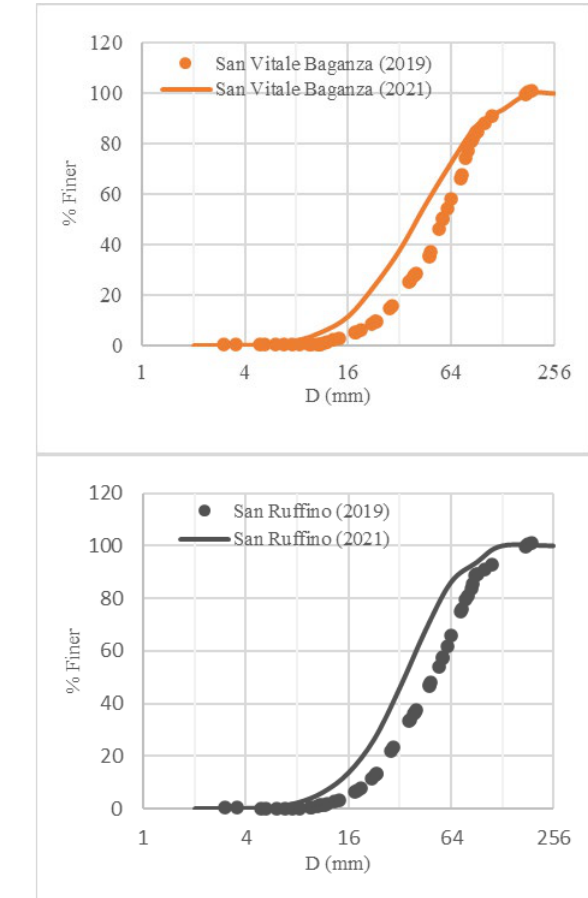
Figure 10. The individual grain size distribution of the surface sediments at each investigated sec- tion (the photogrammetric technique).